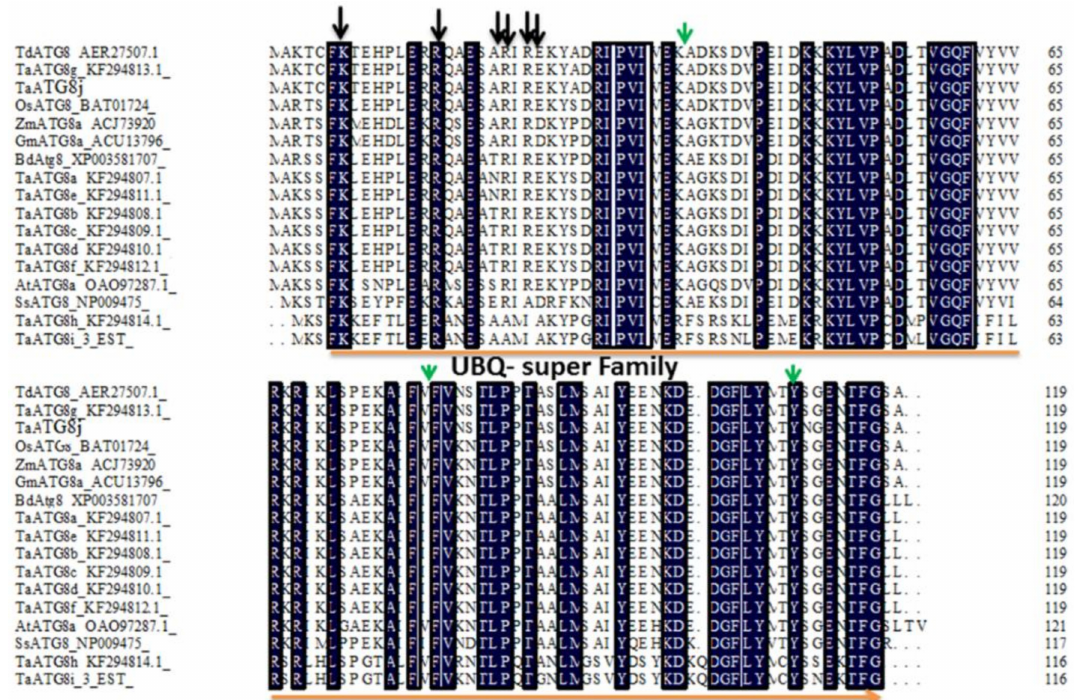
Figure 2. Multiprotein sequence alignment of TaATG8j against other members of the ATG8 family. Identical amino acids are indicated in black. Black and green arrows indicate tubulin- and ATG7-binding sites, respectively. Orange line indicates the upiquitin-like (UBQ) super family protein. Ta: Triticum aestivum ; Td: Triticum dicoccoides ; Zm: Zea mays ; Os: Oryza sativa ; Gm: Glycine max ; Bd: Brachypodium distachyon ; Sc: Saccharomyces cerevisiae ; and At: Arabidopsis thaliana